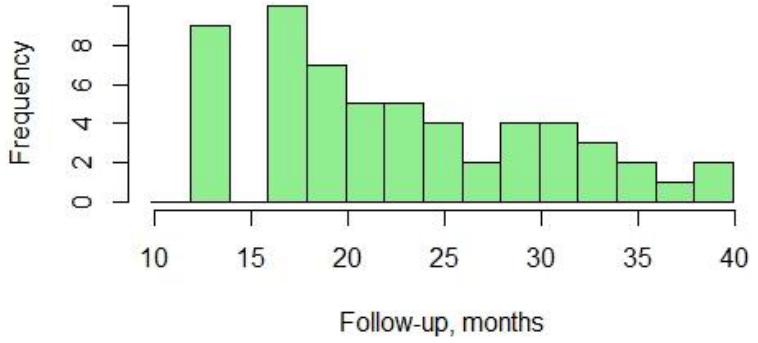
Figure 4. The distribution of the follow-up period.